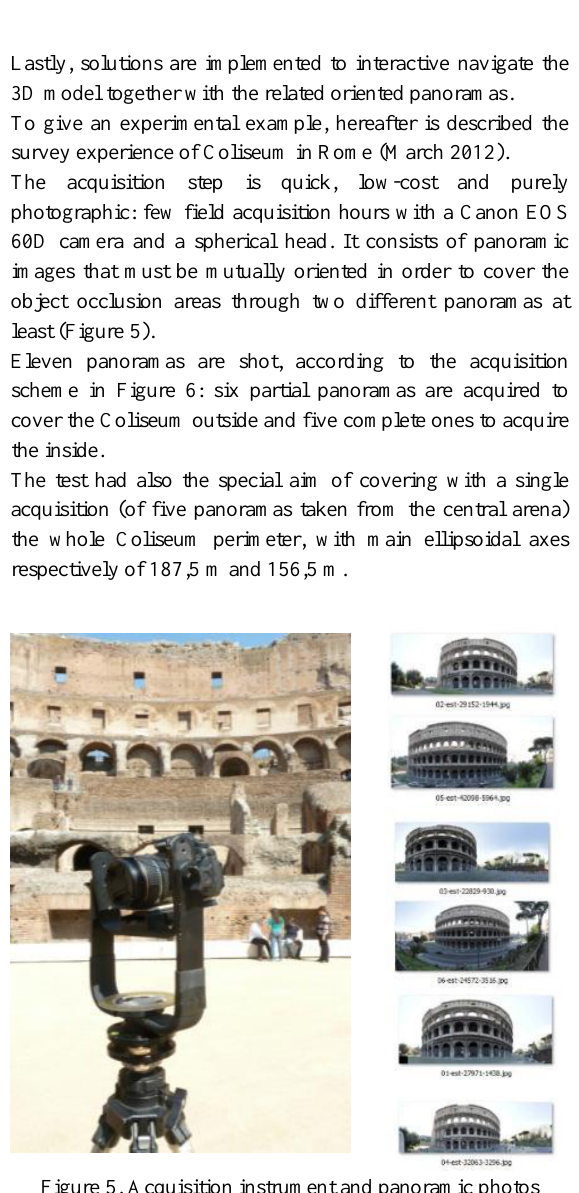
Figure 5. Acquisition instrument and panoramic photos